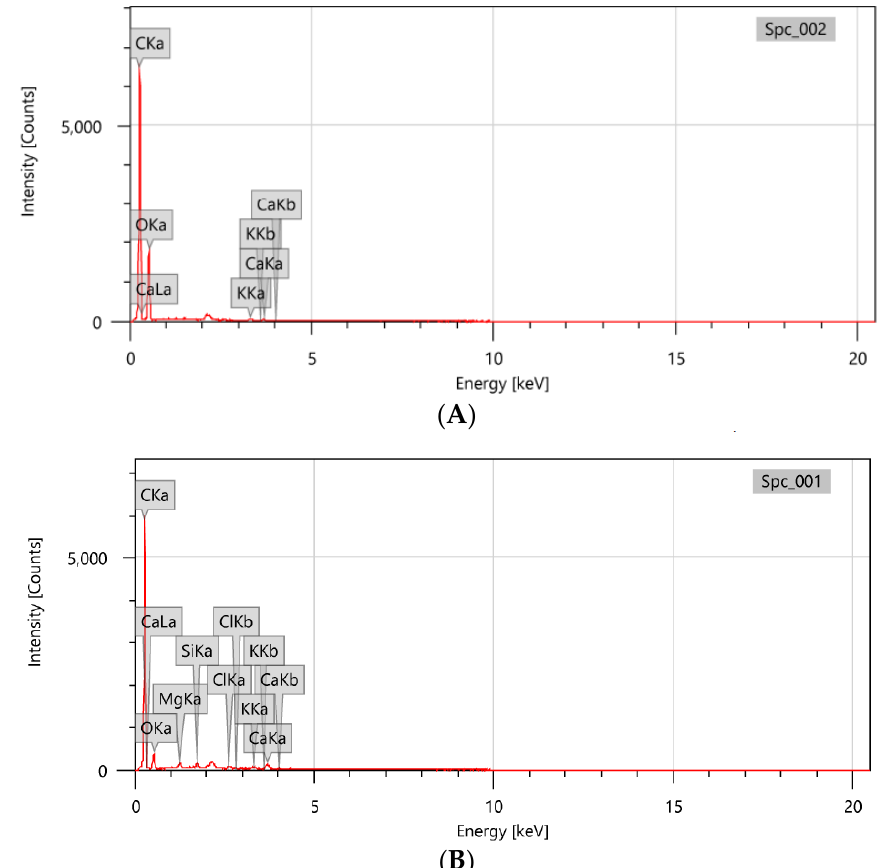
Figure 3. EDX graph of ( A ) Raw-RGL and ( B ) AC-RGL adsorbents. Table 1. The surface element analysis of Raw-RGL adsorbent.